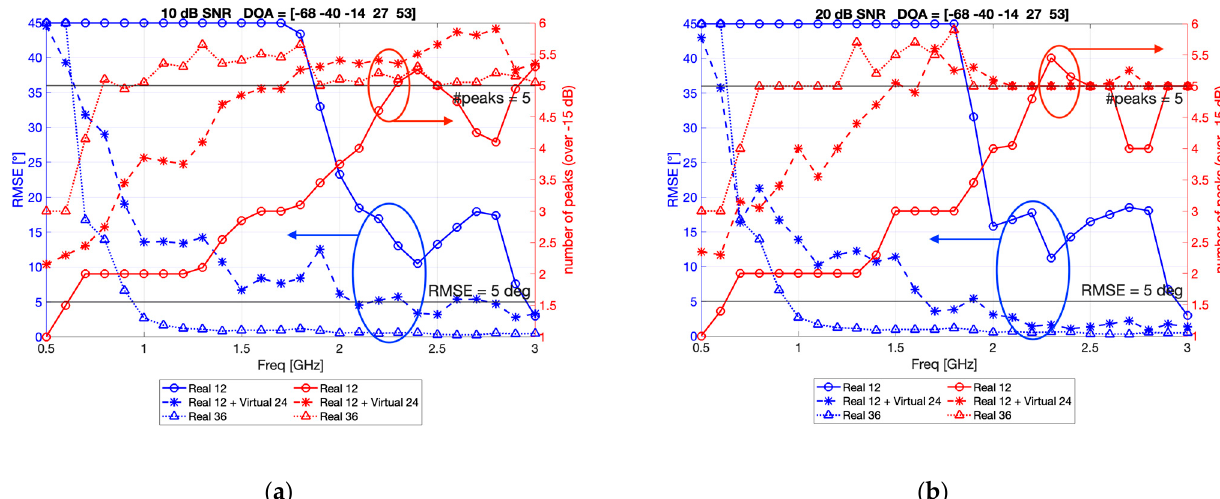
Figure 3. RMSEs from the DOA estimation and the number of peaks when the DOA was − 68, − 40, − 14, 27, and 53° under ( a ) 10 dB SNR and ( b ) 20 dB SNR.